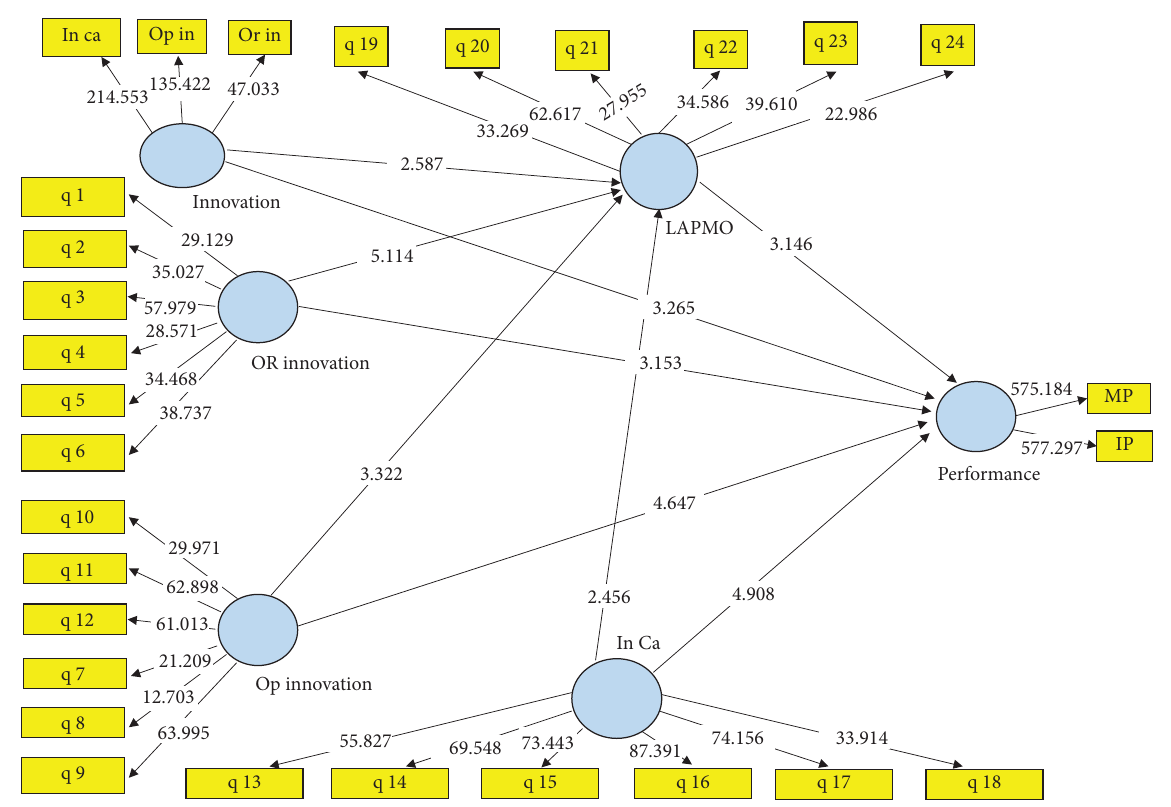
Figure 7: Structural equation model of the study in signifcance coefcients of t-statistic (made by